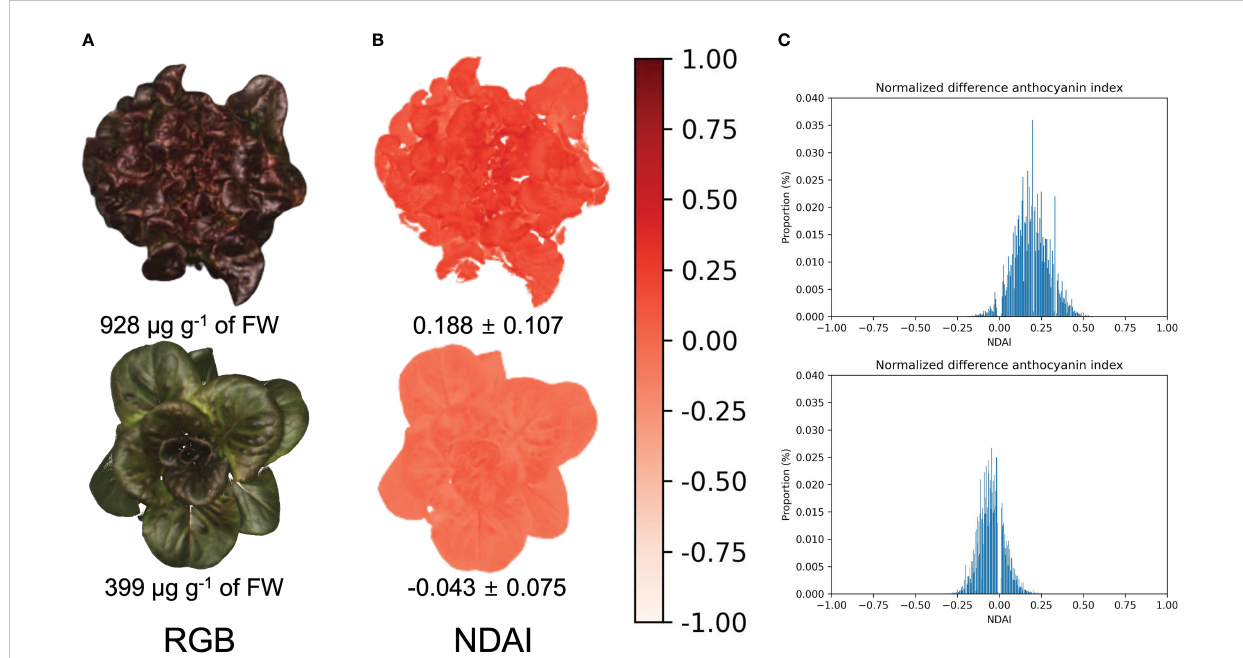
FIGURE 5 Canopy RGB (A) and normalized difference anthocyanin index ( B ; NDAI) images of red lettuce cultivars ‘ Rouxai ’ (top) and ‘ Teodore ’ (bottom) and their corresponding histograms (C) . The scale bar on the right side represents the NDAI values within these NDAI images. Values below the NDAI images represent mean ± standard deviation of NDAI within the NDAI images, while values below the RGB images represent the anthocyanin